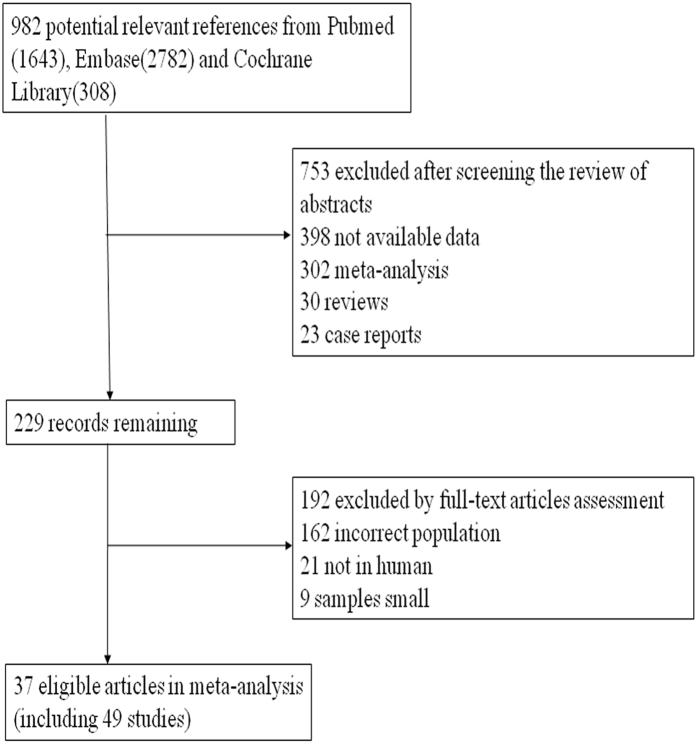
Flow diagram of the study selection process.